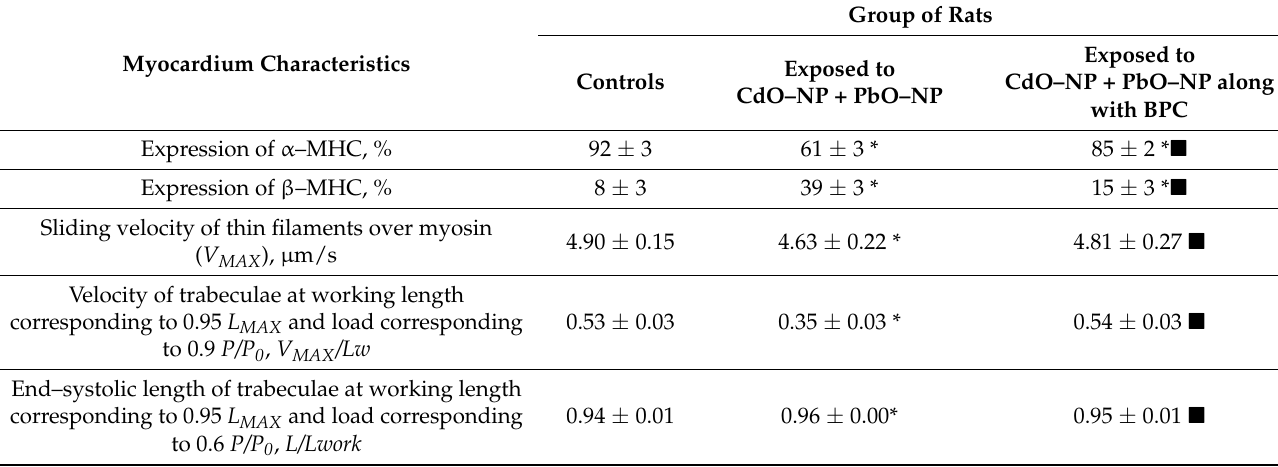
Table 4. Some characteristics of the myocardium in control rats and in those exposed to lead and cadmium oxide NP combination with and without bioprotection (X ±